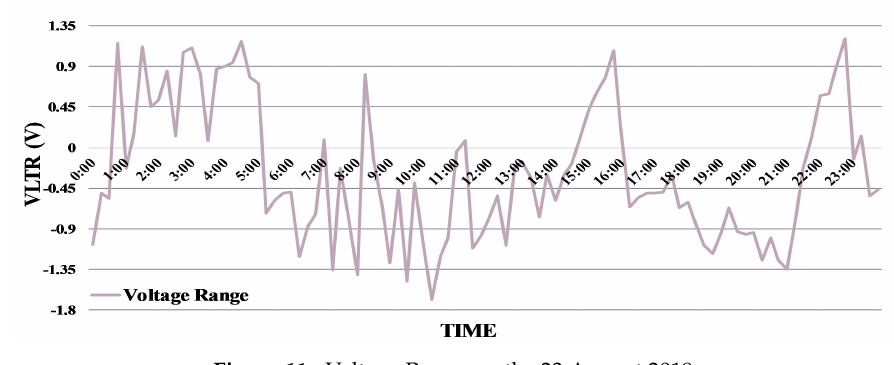
Figure 11. Voltage Range on the 23 August 2019.